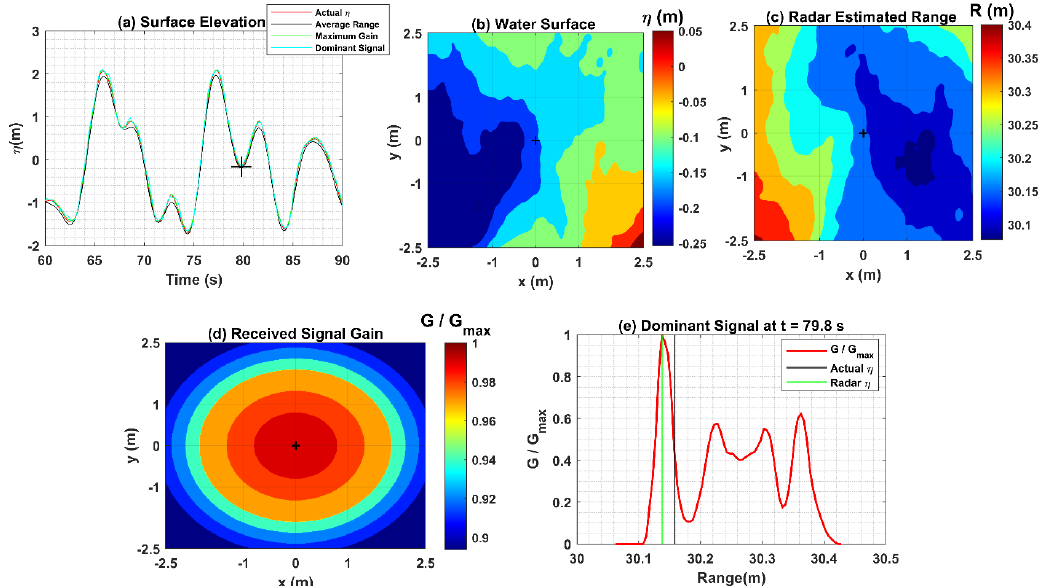
Figure 12. Radar dominant signal processing for a trough of depth − 0.2 m occurred at time step of 79.8 s: ( a ) time series plots of actual surface elevations and that from the Radar signals; ( b ) water surface covered by the Radar footprint (5 m × 5 m); ( c ) Radar estimated ranges over its footprint; ( d ) normalized received signal gain over the Radar footprint; ( e ) normalized dominant signal gain as a function of